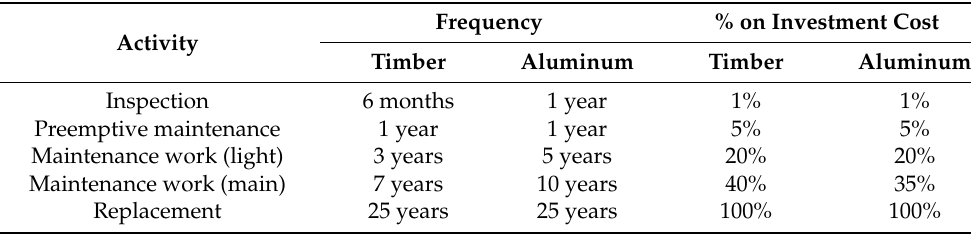
Table 6. Maintenance and replacement schedule.